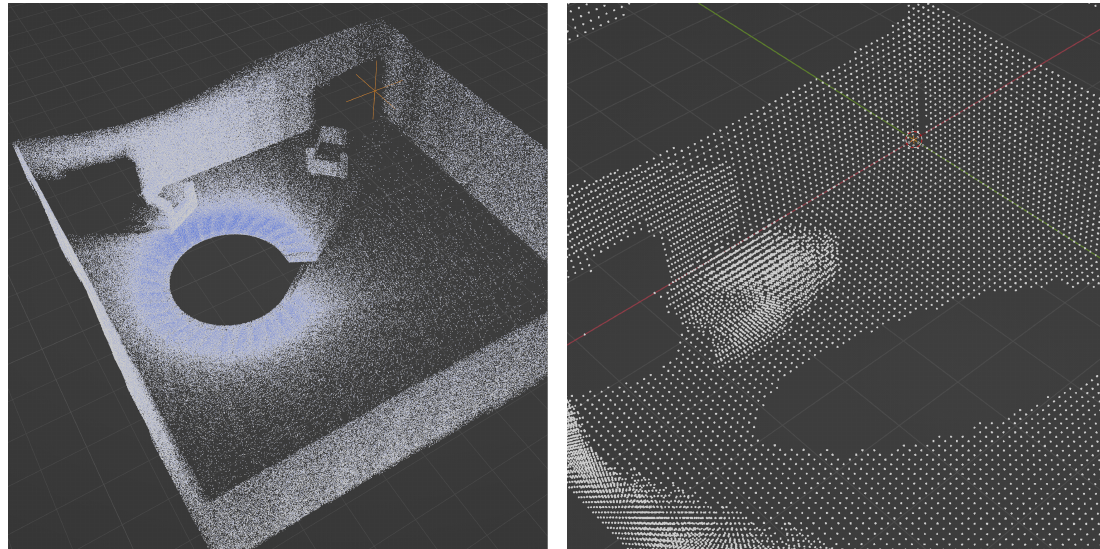
Figure 7. Figure showing point cloud and voxel